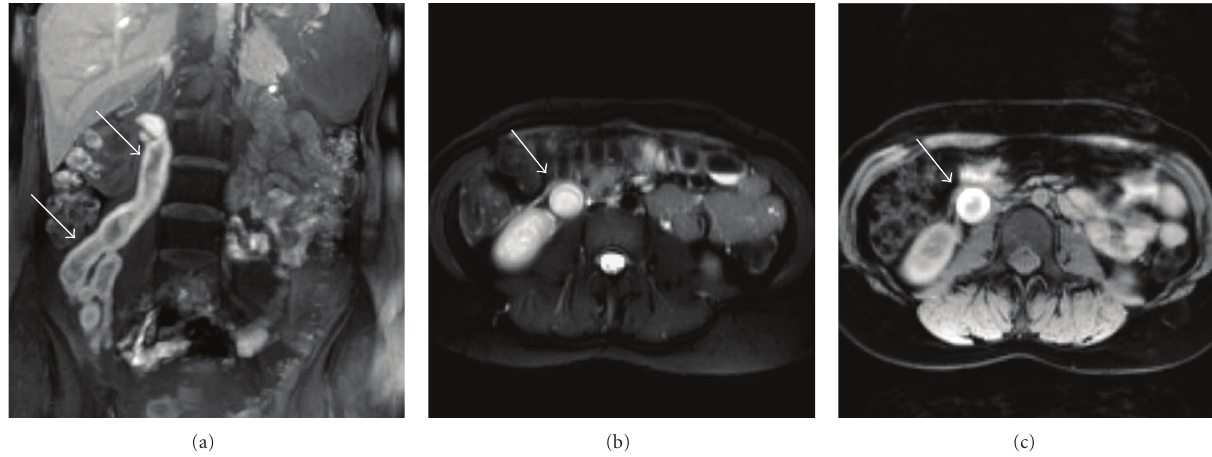
Figure 3: MR images show subacute right ovarian vein thrombosis. Coronal T1-weighted image (a) demonstrates an enlarged right ovarian vein showing increased signal (arrow) with an isointense central focus and axial T2-weighted image (b) shows high signal (arrow) indicative of methemoglobin within a complex thrombus. Contrast-enhanced axial T1-weighted image (c) reveals significant contrast enhancement of the vessel